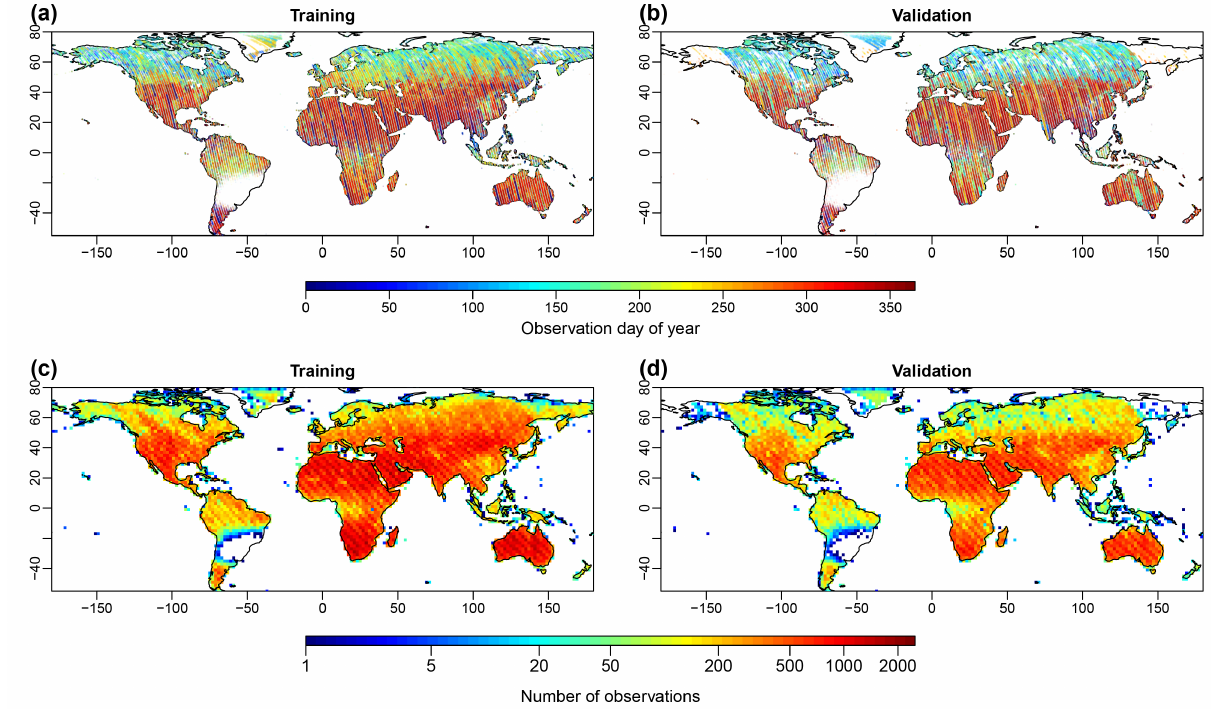
Figure 1. Samples that were used for NN training (years 2015 and 2016) and validation (2014 and 2017). Panels (a) and (b) show the spatial distribution of observation day of year (DOY) and panels (c) and (d) show the spatial distribution of the sample density. Each point in panels (a) and (c) represents a 0.05 ◦ training grid cell. Limited observations in South America were caused by the South Atlantic Anomaly (Sun et al.,